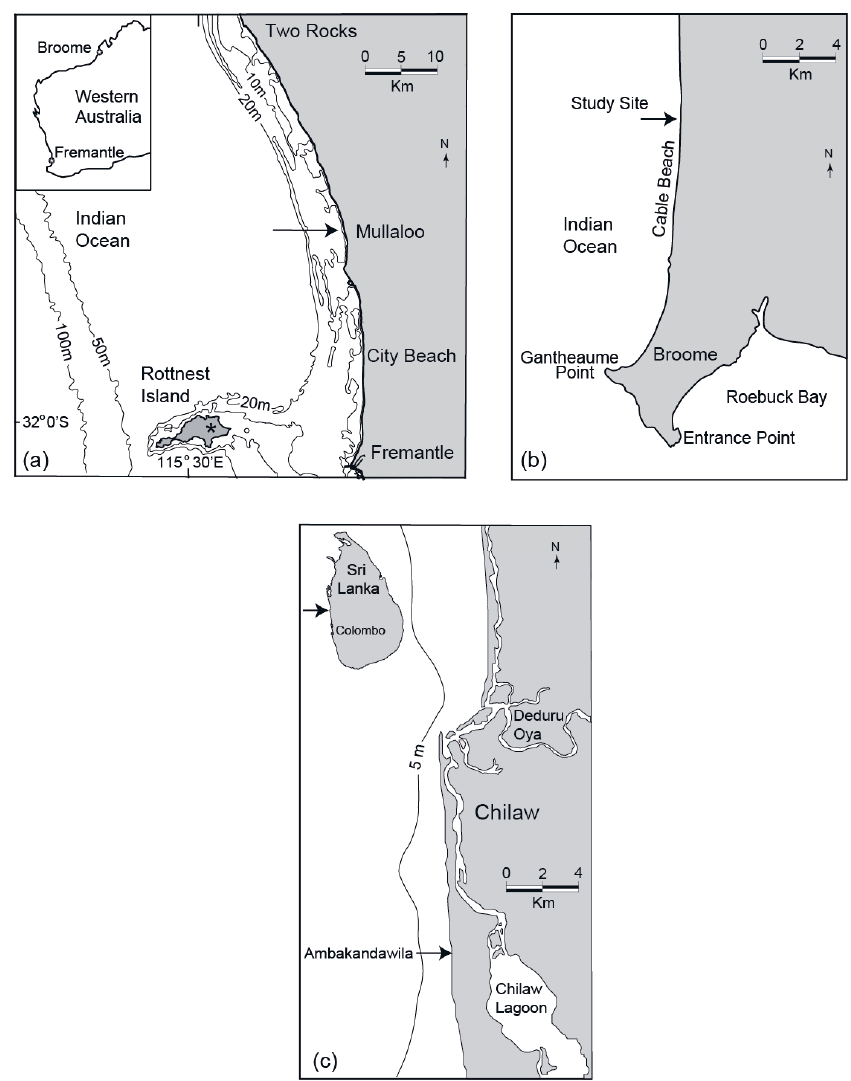
Figure 1. Location maps of the study sites. ( a ) Mullaloo Beach, Perth, Western